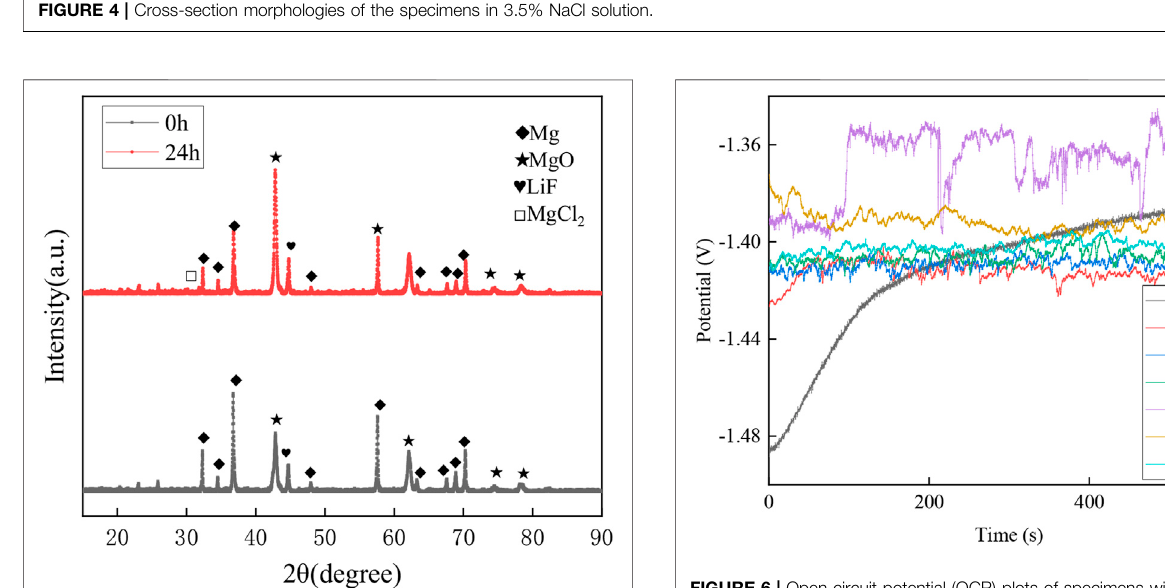
FIGURE 6 | Open circuit potential (OCP) plots of specimens with different immersion time.